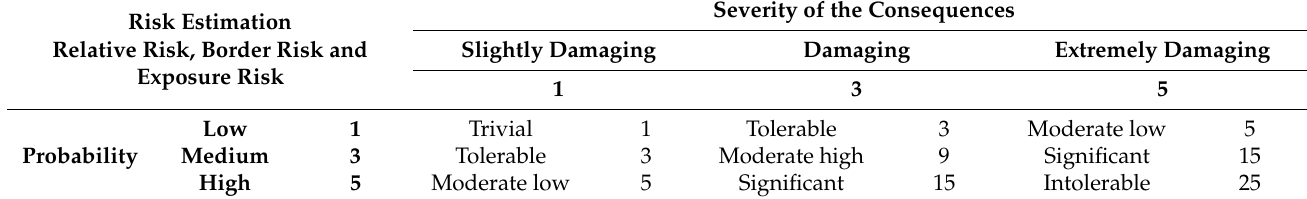
Table 3. Characteristic Values: Relative Risk, Border Risk and Exposure Risk.